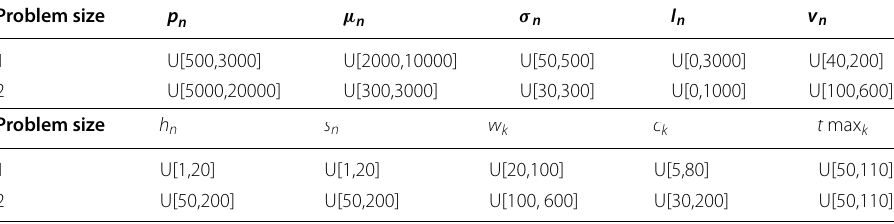
Table 4 The ranges of the model parameters for generating test problems in two sizes Problem